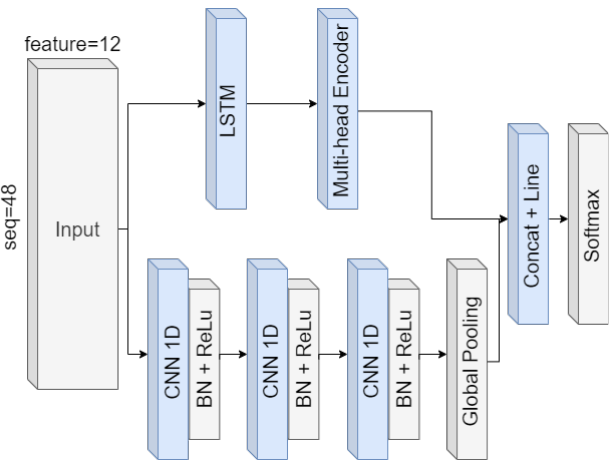
Figure 7. MALSTM-FCN structure diagram.